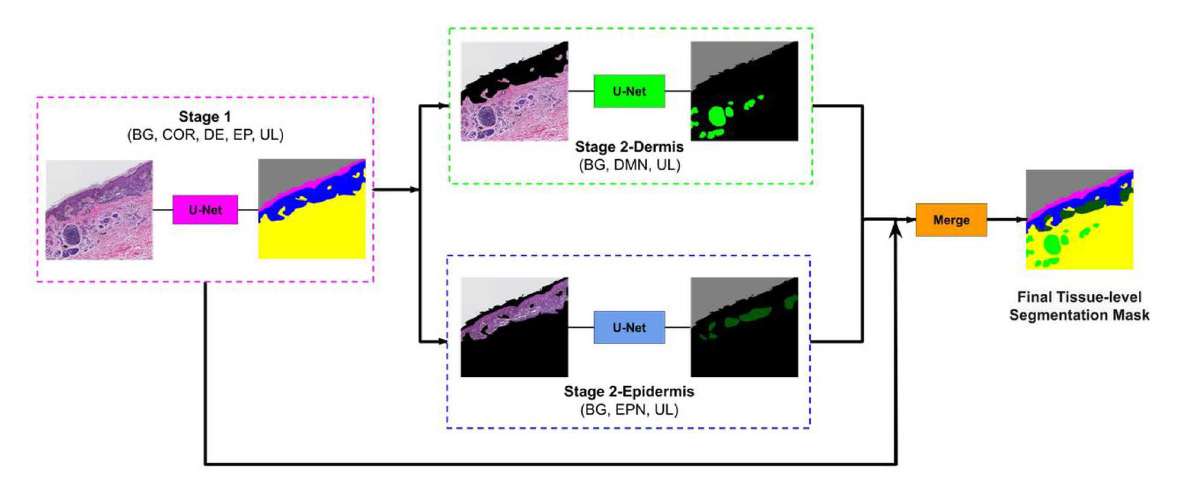
FIGURE4 Overview of our approach. The image first goes to stage 1 and the segmentation mask of entities (COR, Stratum Corneum; EP, Epidermis; DE, Dermis; BG, Background; UL, Unlabeled) in stage 1 is generated. Then this mask is used to remove the epidermis from stage 2-Dermis input and remove the dermis from stage 2-Epidermis input. The modified images are fed to their corresponding trained model. Stage 2-Dermis generates the segmentation masks of entities present in the dermis (DMN, Dermal nests), and stage 2-Epidermis generates the entities in the epidermis (EPN, Epidermal nests). In the end, stage 2-Dermis and stage 2-Epidermis segmentation masks are overlaid on the stage 1 mask and the final tissue-level segmentation mask is generated (Reprinted by permission from Springer, Journal of Digital Imaging, “Segmenting Skin Biopsy Images with Coarse and Sparse Annotations using U-Net,” S. Nofallah, M. Mokhtari, W. Wu, S. Mehta, S. Knezevich, C. J. May, O. H. Chang, A. C. Lee, J. G. Elmore, L. G. Shapiro, Copyright